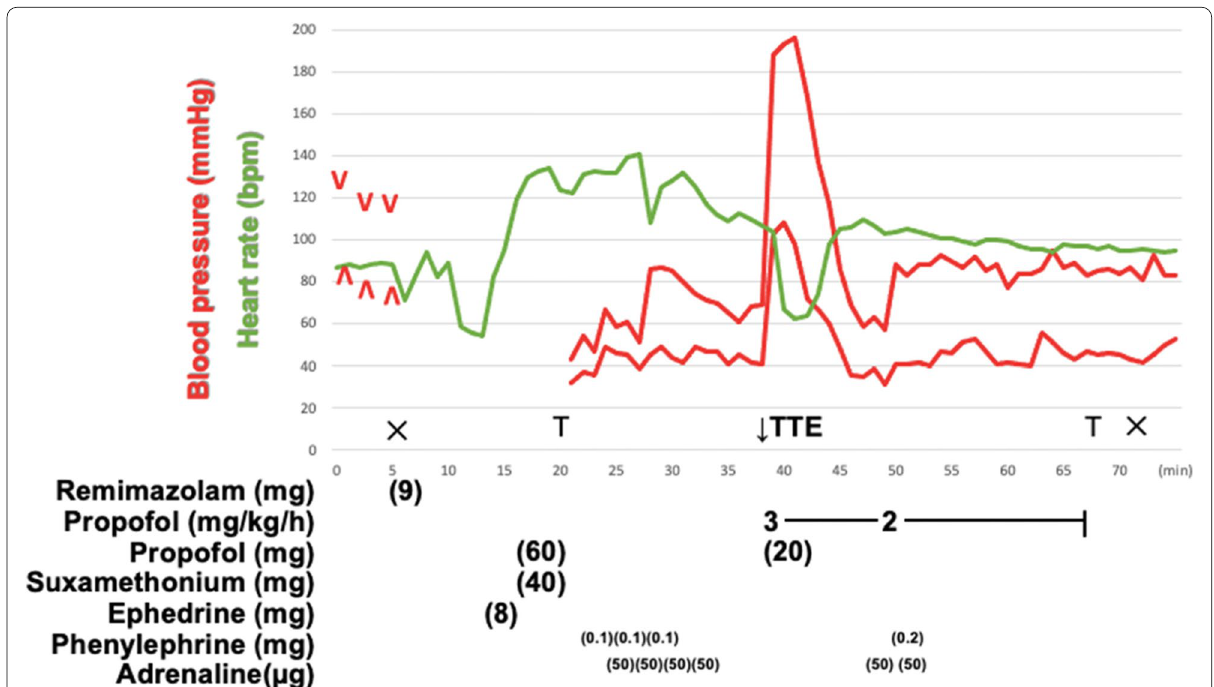
Fig. 2 Time course of general anesthesia in case 2. We were unable to measure blood pressure with the manchette method after remimazolam infusion. It was due to hypotension and the body movement. Following then, we catheterized the radial artery, but it took some time. We were able to palpate the radial artery pulse slightly during this period. TTE: Transthoracic